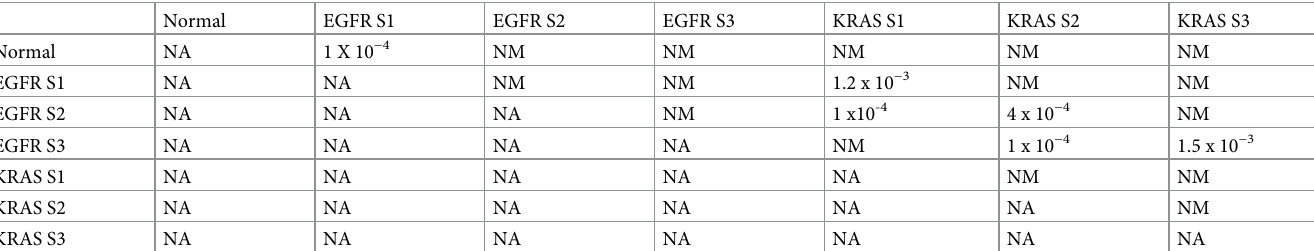
Table 1. P-value results of pairwise Mann-Whitney testing select conditions shown in Fig 2C, cell volume of near-euploids. Normal Normal